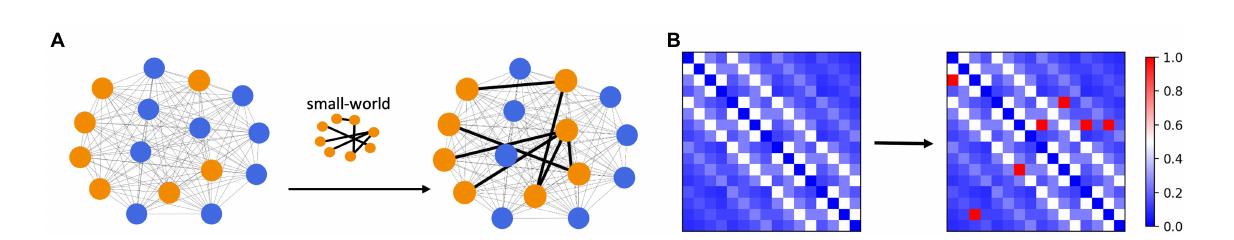
FIGURE 2 Diagram of network connection structure. (A) The strength of connections between nodes in a fully connected network is inversely proportional to the between-node path. The connection pattern between lesion nodes (orange) is topologically specific (small-world connection as an example). The strength of the connection between the lesion nodes was significantly greater than the remaining connections (B) The connectivity strength between lesion nodes is extremely prominent, much higher than that between non-lesion nodes, and this matrix can be used as the connectivity matrix Sij in the